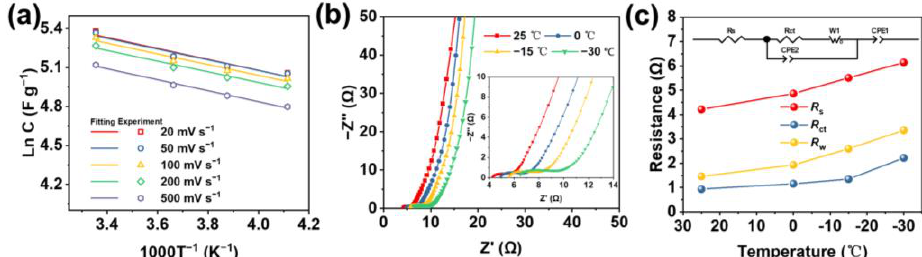
Figure 6. Temperature-insensitive electrochemical mechanism of aligned Ti 3 C 2 T x aerogel electrode. ( a ) Arrhenius relationship between ln C and 1000 T −1 at different scan rates; ( b ) Nyquist plots with the inset of enlarged mid-high-frequency regions at different temperatures; ( c ) Fitted values of resistive elements in the equivalent circuit (inset).